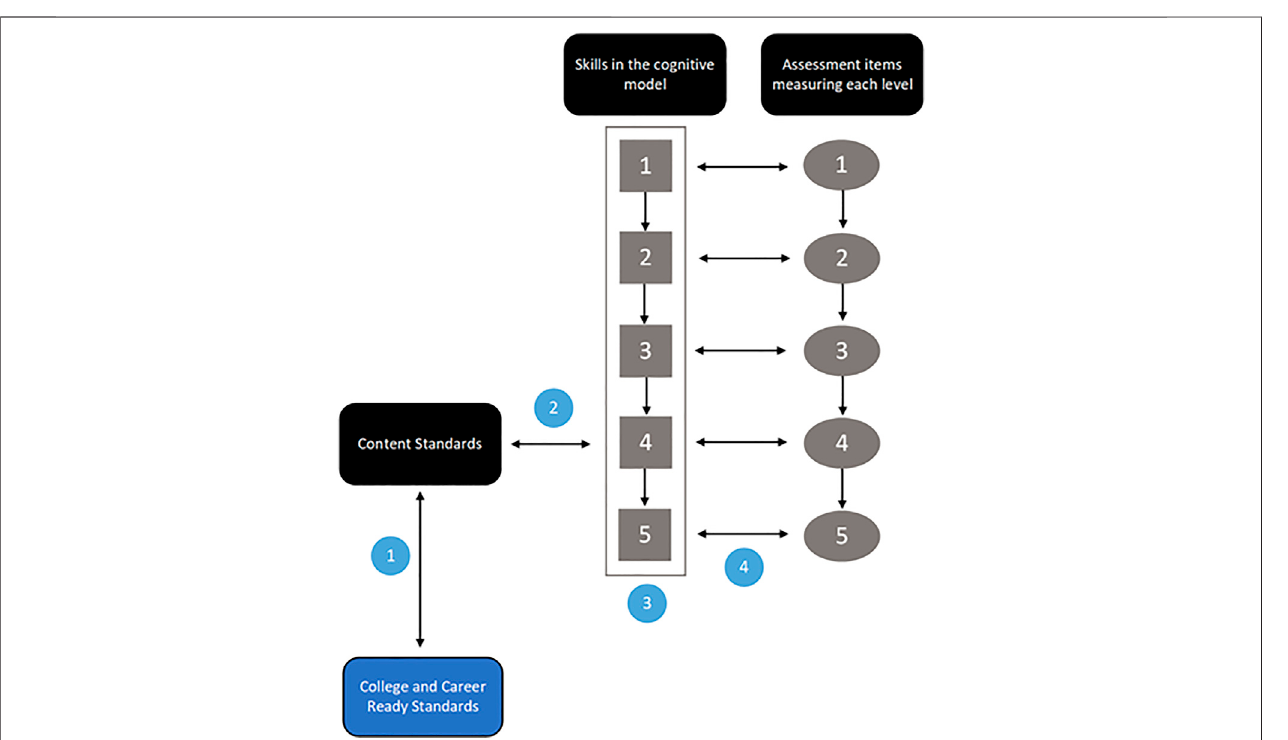
FIGURE A1 | Relationships among content structures of the DLM assessment system. 1) Alternate content standards specify academic targets and are aligned to collegeandcareerstandards.2)Foreachalternatecontentstandard,skillsinthecognitivemodel(learningmap)alignwiththestandardasthe “ target ”